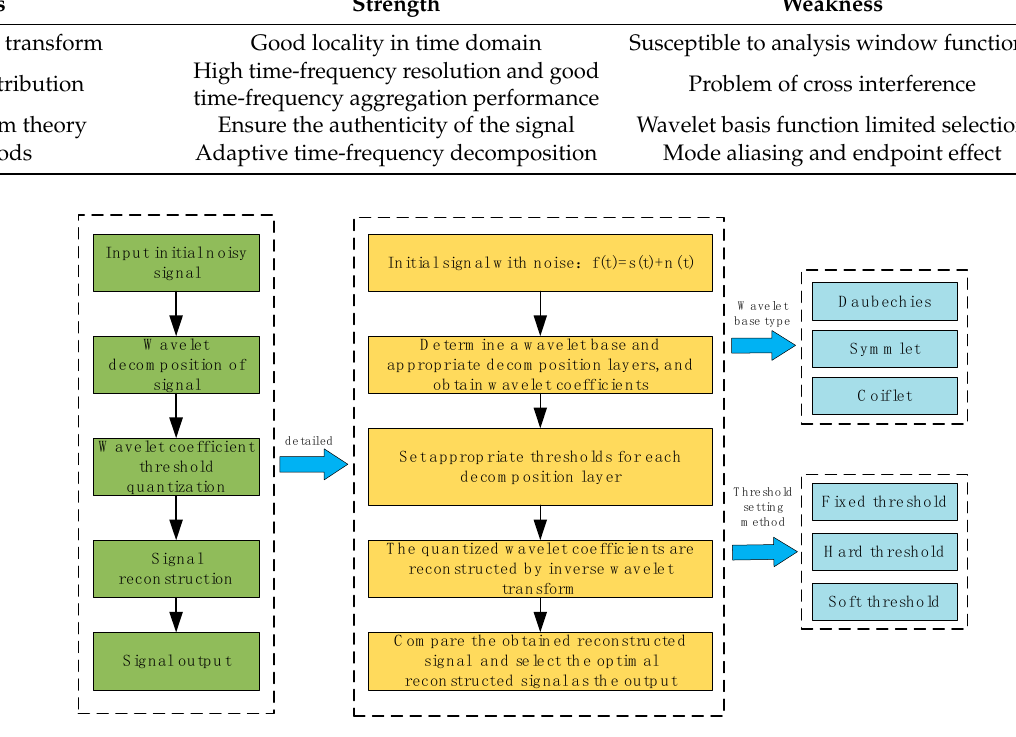
Figure 4. Basic flow of wavelet denoising method.